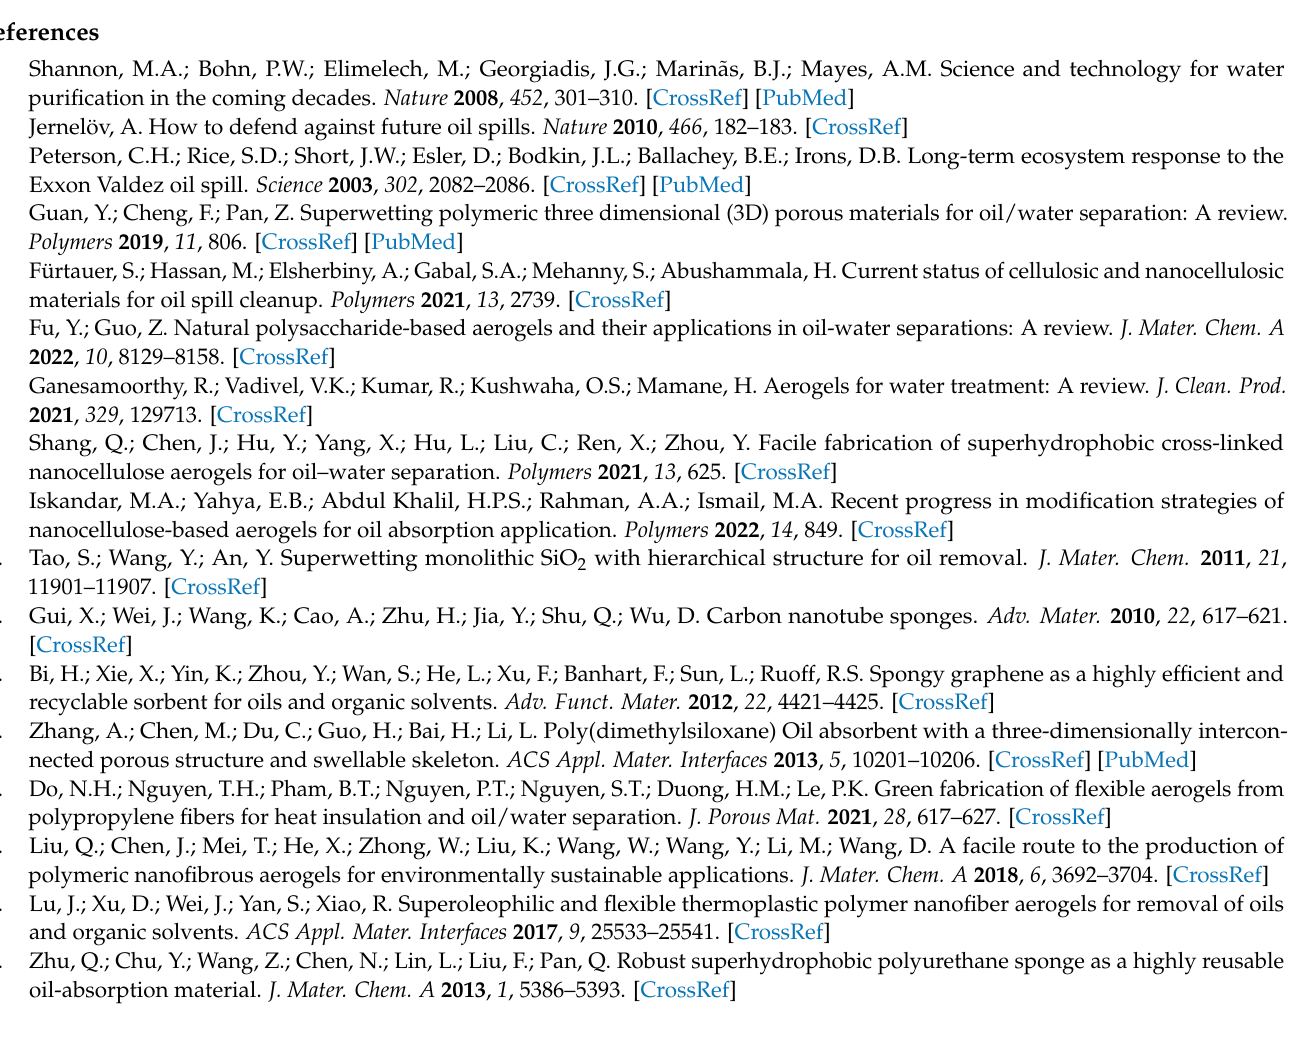
Figure S5: Water contact angles of GIAs as a function of GO contents; Table S1: Surface tensions of organic liquid/oil absorbed by